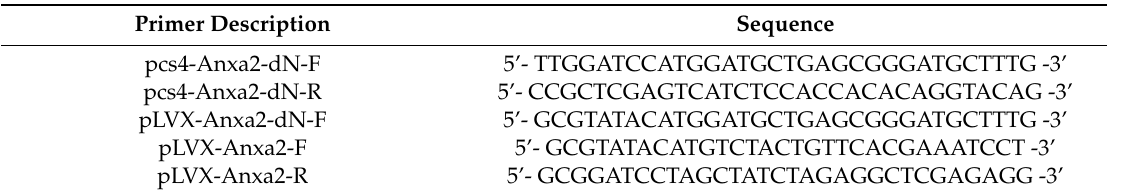
Table 1. Primers for vector